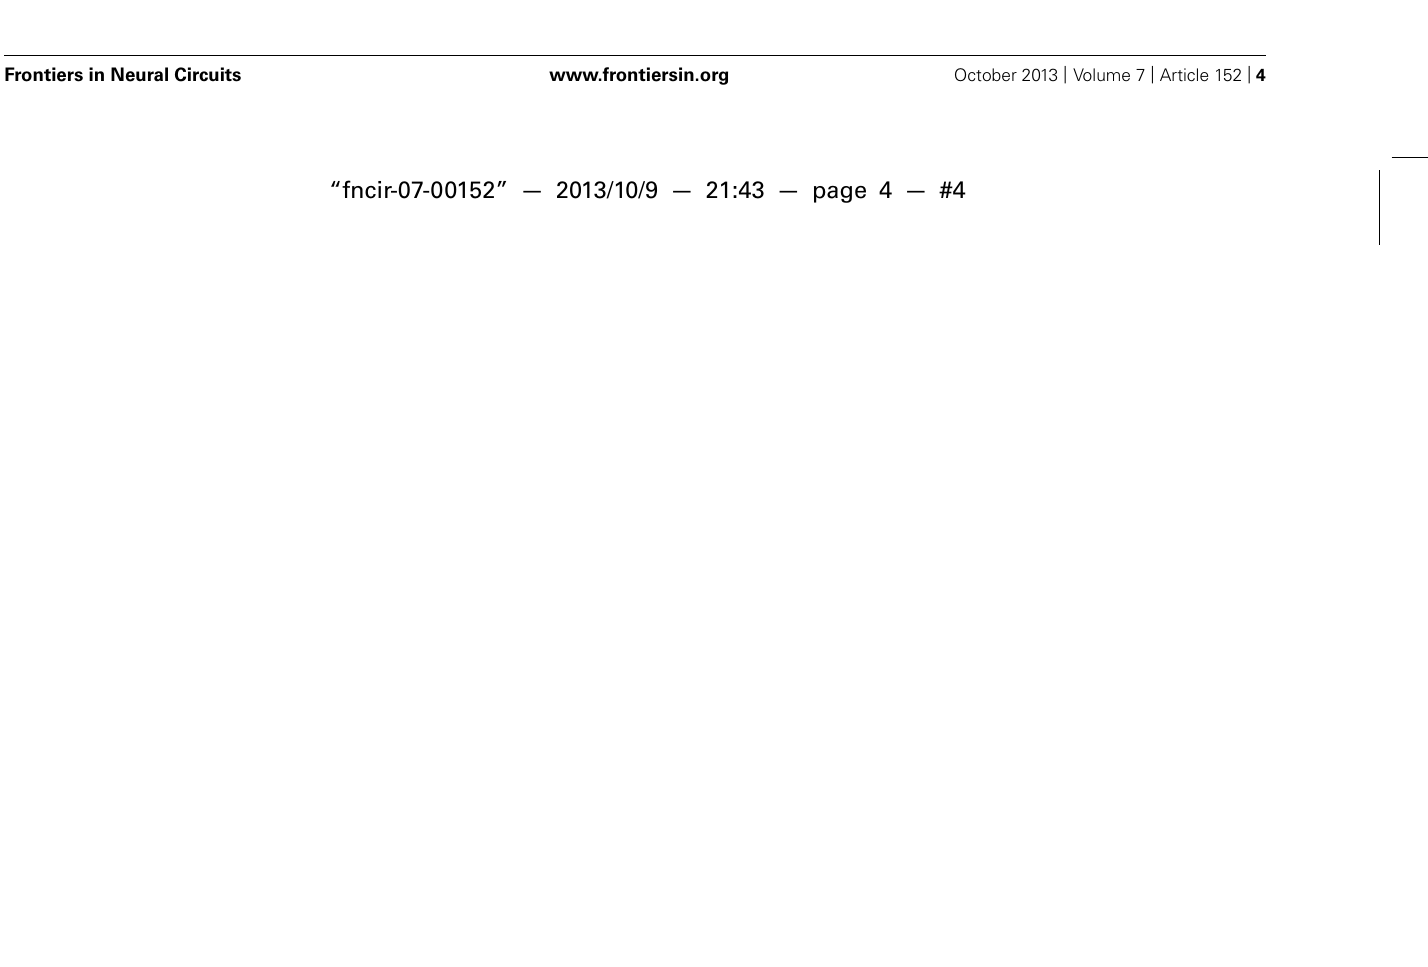
cannot be ruled out; in this case, Gq protein-mediated PKC activation could also induce ERK activation (Choi et al., 1999; Figure 2